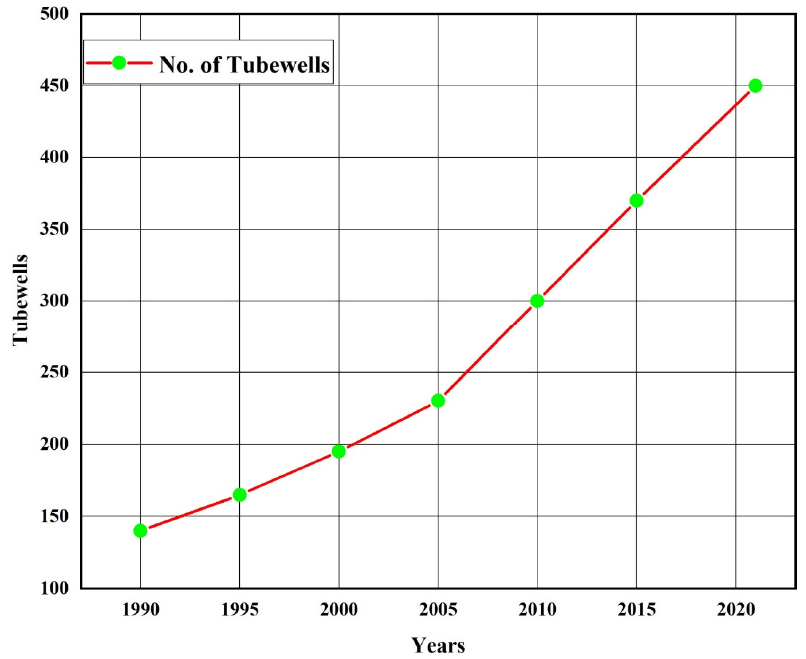
Figure 15. Temporal expansion of tube-wells in the study area.